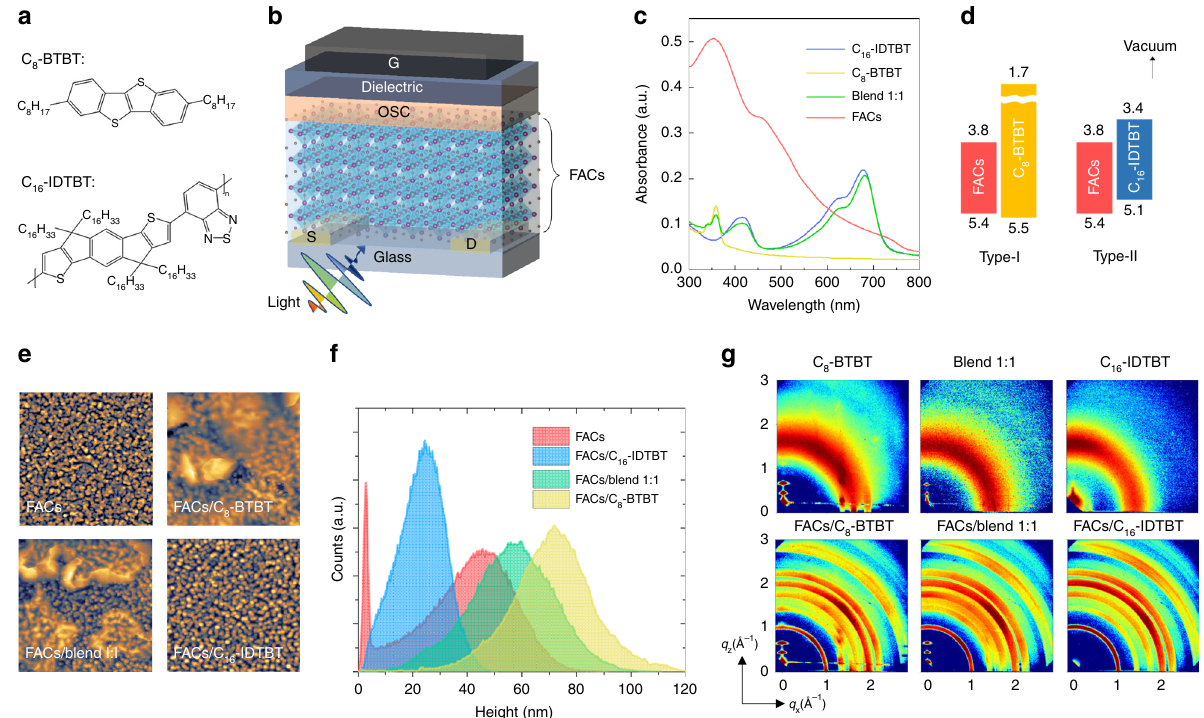
Fig. 1 Perovskite heterojunction phototransistors. a Chemical structures of a small molecule C 8 -BTBT and a copolymer C 16 -IDTBT. b Schematic of HJPT con fi gured in a TG-BC architecture, where G, S and D denote the gate, source and drain electrodes, respectively. An MHP/organic semiconductor (OSC) heterostructure (FA 0.83 Cs 0.17 PbI 2.7 Br 0.3 , i.e. FACs, as the MHP layer) is employed as a dual function photoresponsive transistor channel. Incident light absorbed by the FACs layer can trigger the photodetection functionality in HJPTs. c Ultraviolet – visible (UV-vis) absorption spectrum for C 16 -IDTBT, C 8 - BTBT, an organic blend of C 8 -BTBT:C 16 -IDTBT in a ratio of 1:1 (blend 1:1) and FACs. d Energy (in eV) band alignments of type-I and type-II heterojunctions for FACs/C 8 -BTBT and FACs/C 16 -IDTBT, respectively. e Representative AFM topographic images (5 µ m × 5 µ m) for different MHP/OSC bilayer